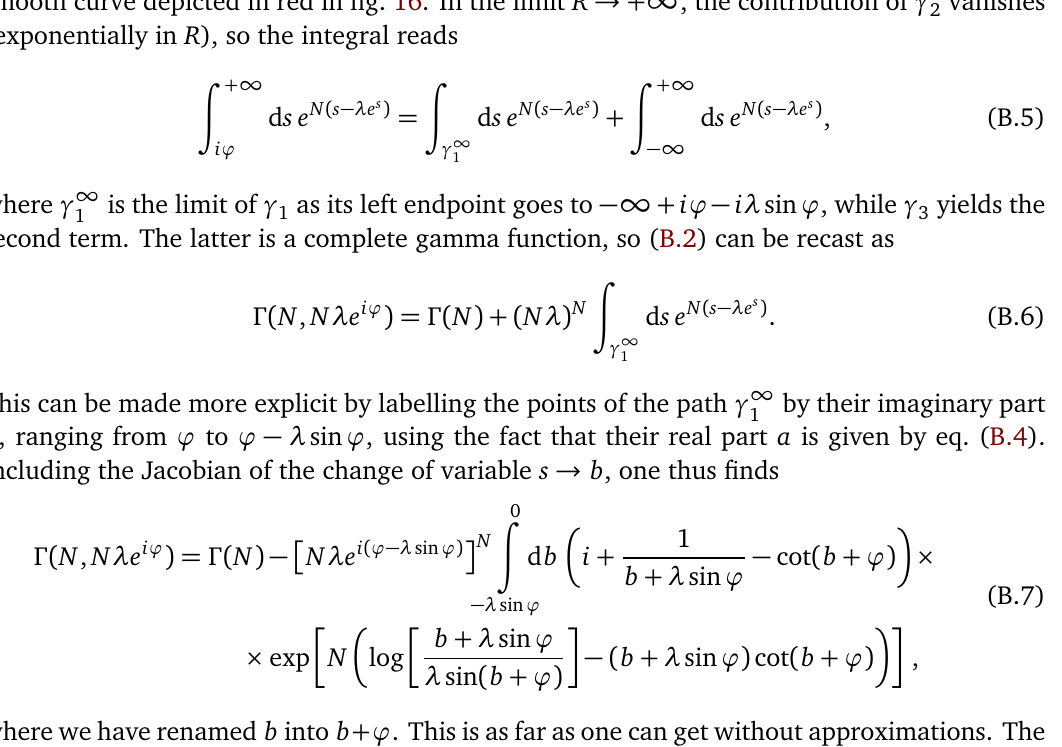
Figure 16: Integration curves for (B.2) at λ > 1. When ϕ > ϕ contains three pieces γ not (but its contribution to the integral vanishes in the limit R → + ∞ ). The same kind of piecewise-smooth path is taken when λ ≤ 1. Conversely, when λ > 1